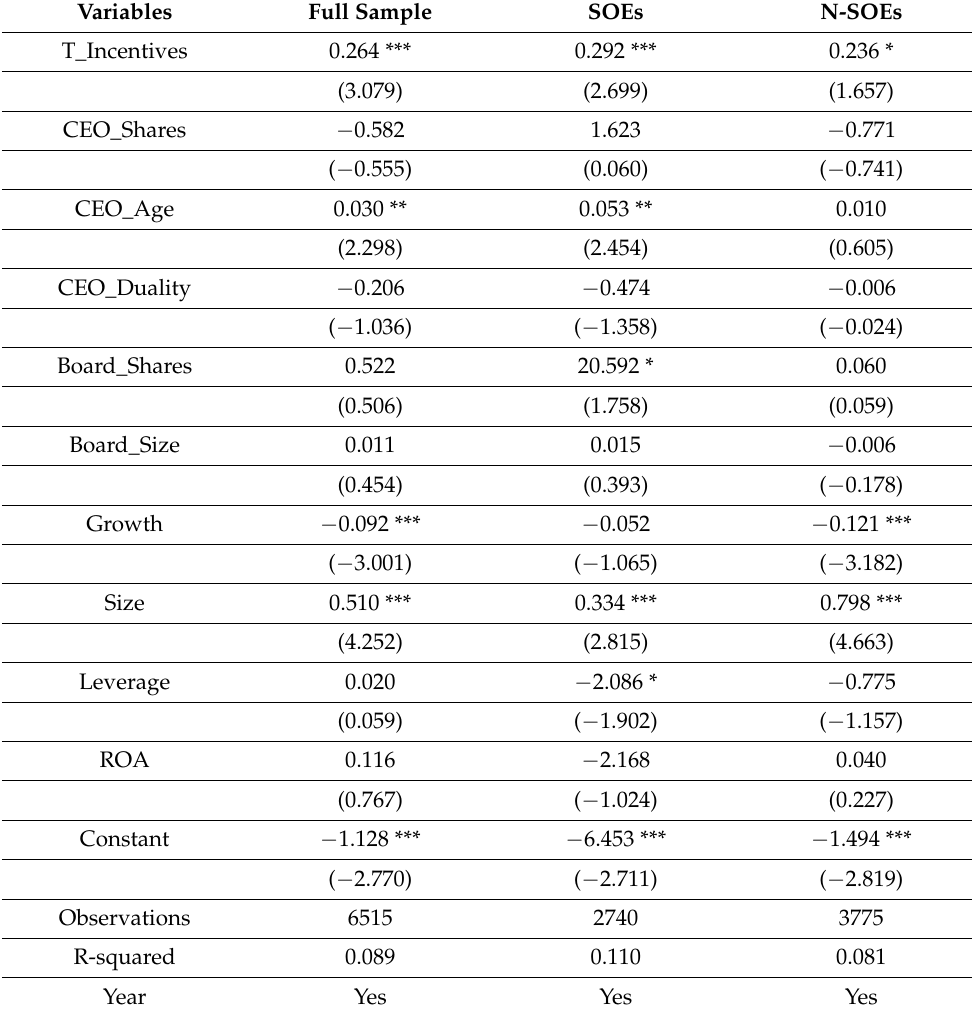
Table 5. Endogeneity test: fixed-effect